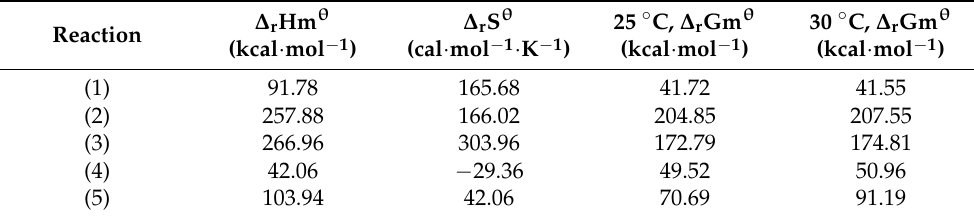
Table 6. Thermodynamic calculations.